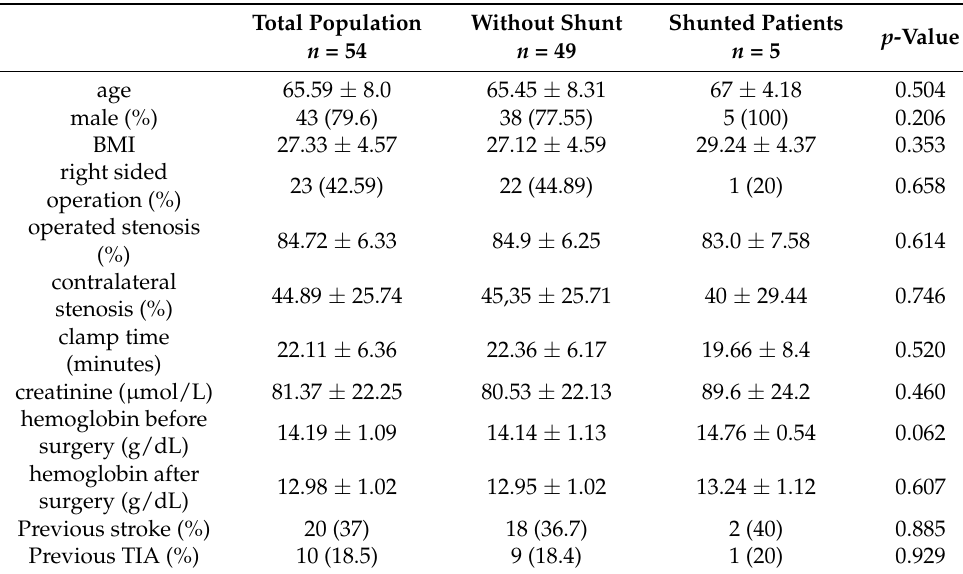
Table 1. Demographics and clinical factors.